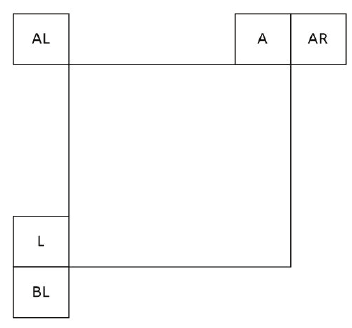
Figure 5. MPMs: neighbors of the current PU in